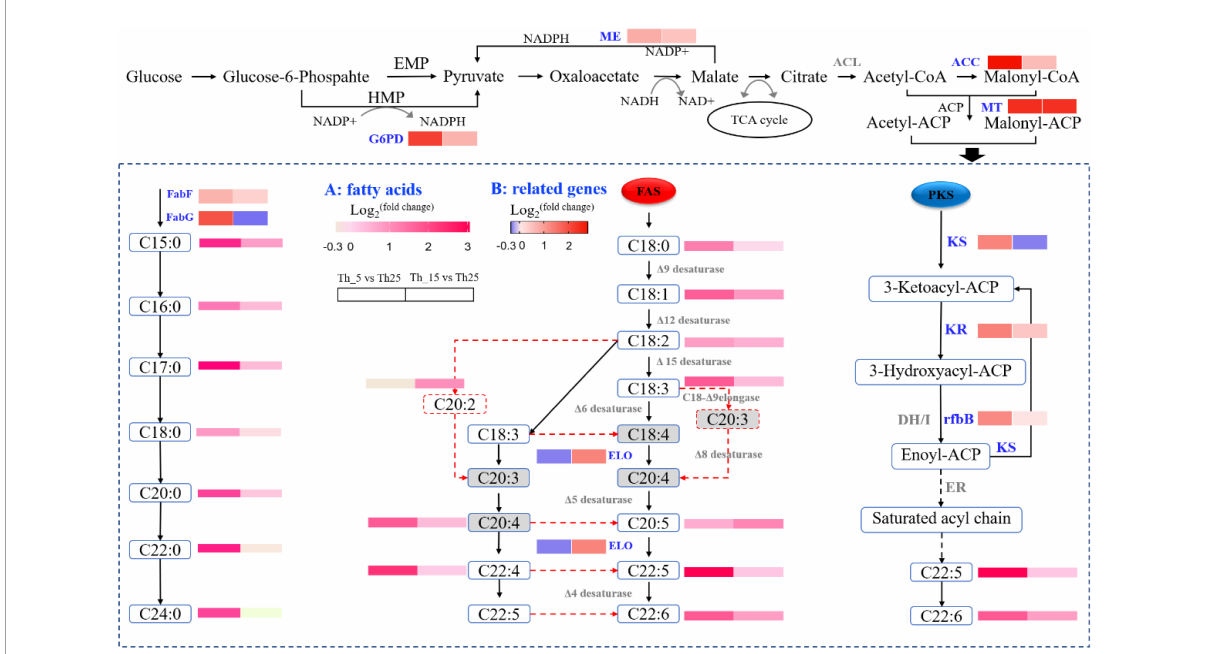
FIGURE3 Diagrammatic representation of significantly differentially expressed genes related to fatty acids biosynthesis pathway under 5 and 15 ◦ C treatment (A: the change of key metabolites; B: the change of key genes in the pathway). ME, malic enzyme; ACC, acetyl-CoA carboxylase; MT, malonyl-CoA:ACP transacylase; G6PD, glucose-6-phosphate 1-dehydrogenase; KS, 3-ketoacyl-CoA synthase; KR, ketoreductase; rfbB, dTDP-glucose 4,6-Dehydratase; ELO, fatty acid elongase 3; FabF, 3-oxoacyl-[acyl-carrier-protein] synthase II; FabG, 3-oxoacyl-[acyl-carrier protein] reductase; A, fatty acids; B, related